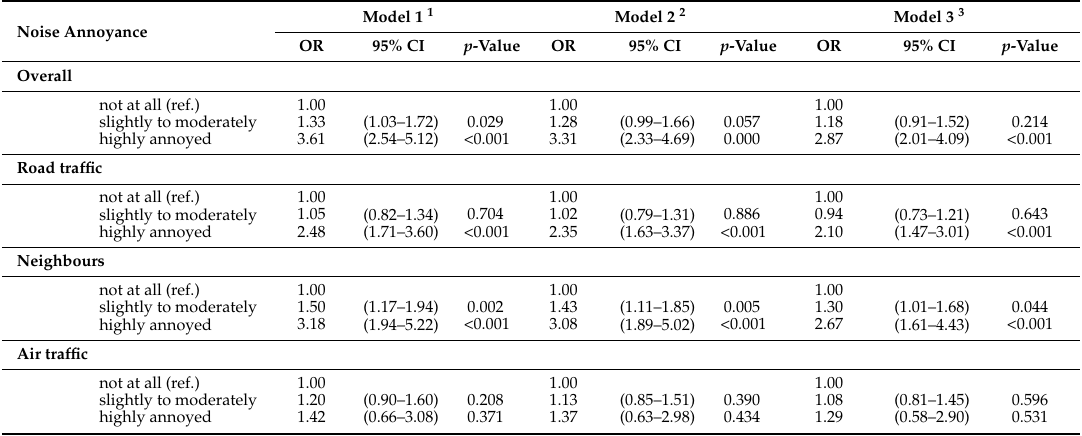
Table 4. Odds ratios of impaired mental health by noise annoyance levels and noise sources in